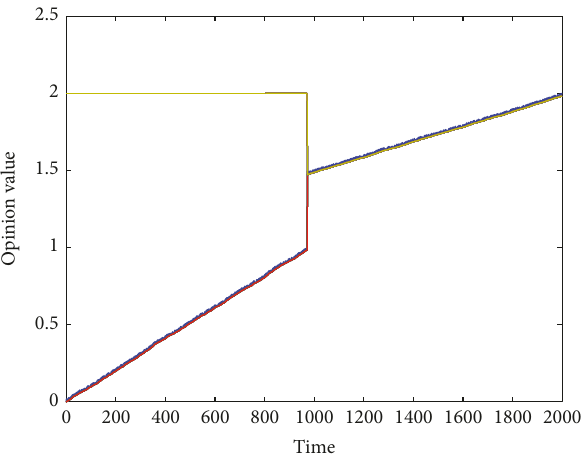
Figure 2: Opinion evolution of system (2)–(5) of 20 agents with noise uniformly distributed on [0,0.04]𝜖 . The initial opinion value 𝑥(0) = [0 0 0 0 0 0 0 0 0 0 2 2 2 2 2 2 2 2 2 2] , confidence threshold 𝜖 = 1 , and noise strength 𝛿 = 0.04 .